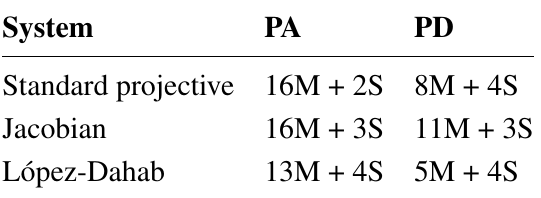
Table 2. Performance of coordinate systems in binary extension